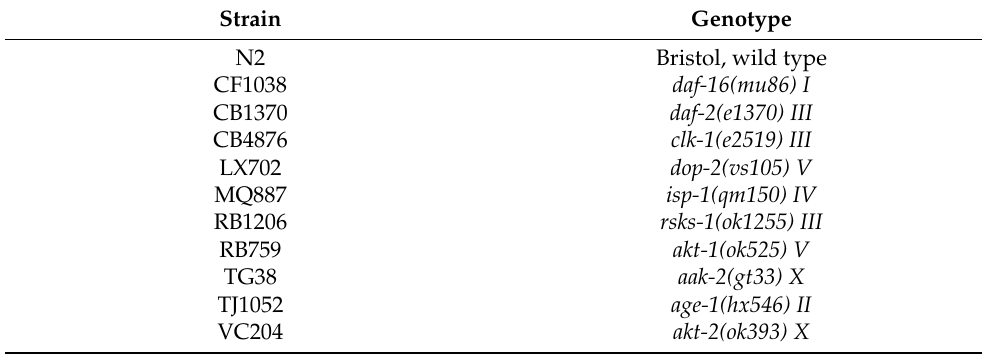
Table 1. List of C. elegans strains used in this study. Strain Genotype N2 Bristol, wild